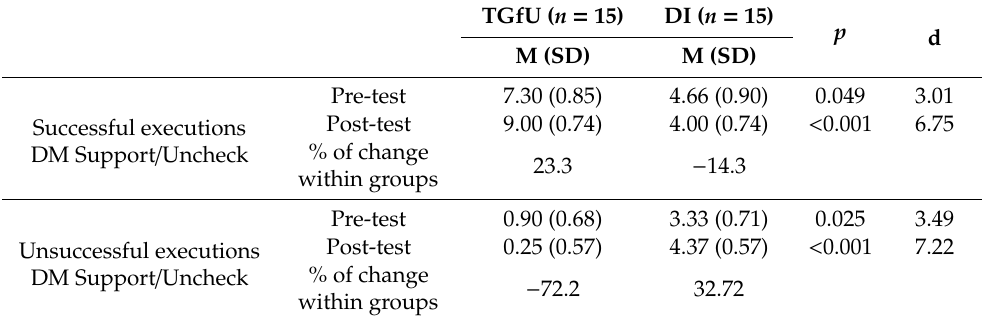
Table 6. Game Performance Evaluation Tool analysis of the attacking player without the ball according to the pedagogical approach (Teaching Games for Understanding [TGfU] vs. Direct Instruction [DI]). TGfU ( n =